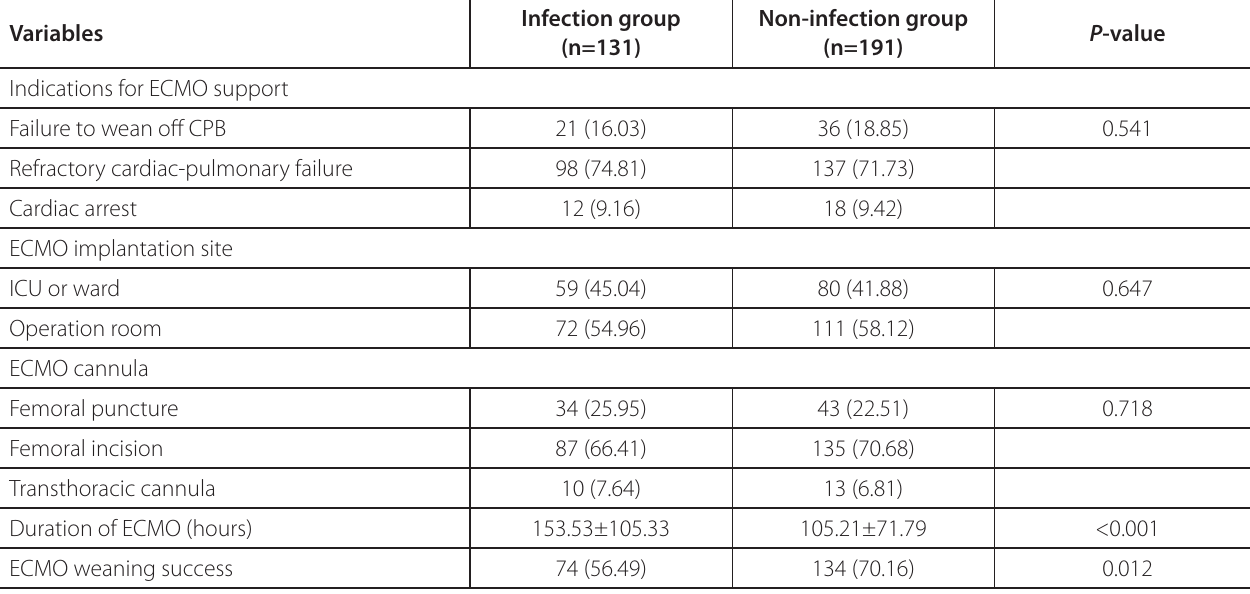
Table 2 . Patients’ ECMO-related parameters and